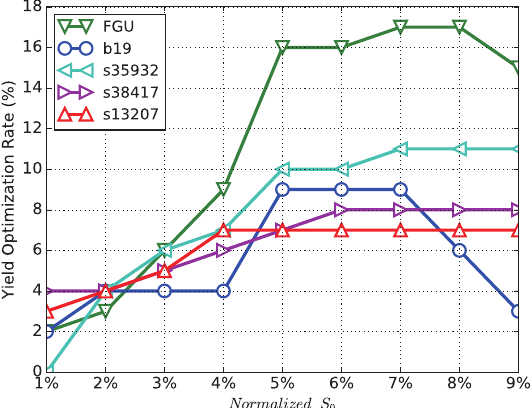
Figure 13. The influence of Normalized _ S 0 on Yield Optimization Rate for different benchmarks.